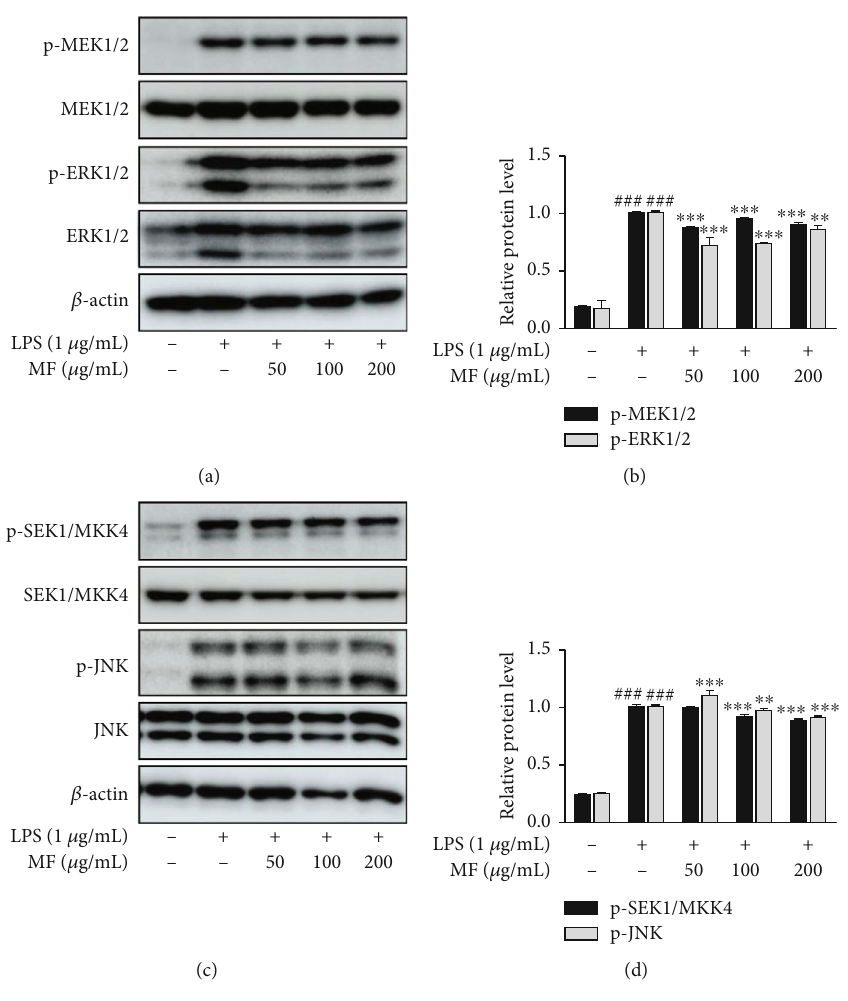
Figure 6: E ff ect of MF on phosphorylation of MEK1/2-ERK1/2 and SEK1/MKK4-JNK pathways in LPS-stimulated RAW264.7 macrophages. The cells were pretreated with MF for 1 h and then stimulated with LPS (1 μ g/mL) for 10 – 20min for analysis of MAPKs. Phosphorylation of MEK1/2-ERK1/2 (a and b) and SEK1/MKK4-JNK (c and d) was determined by western blot. The data are presented as mean ± SD . ### p < 0 : 001 vs. the control group; ∗∗ p < 0 : 01 and ∗∗∗ p < 0 : 001 vs. the LPS-treated group.